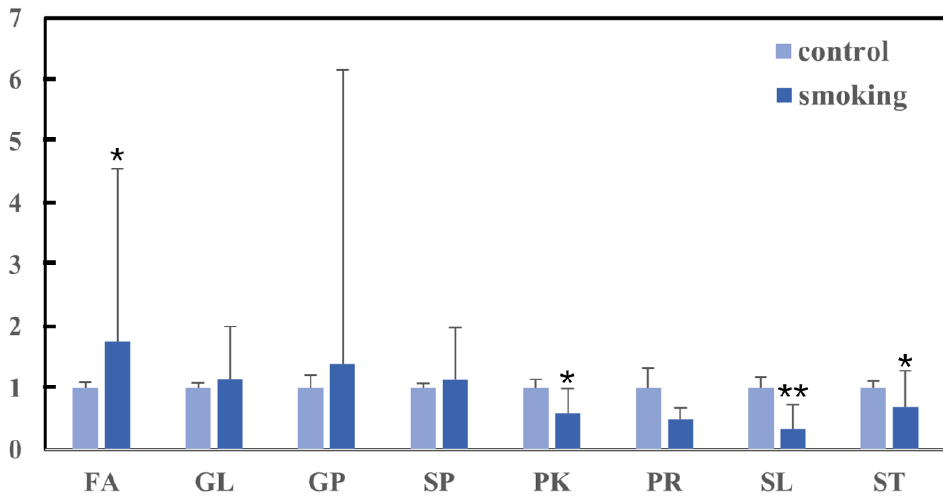
Figure 1. The relative amounts of the eight major lipids in the smoking and control groups. These units are ‘relative to the value for non-smokers, which is set at a value of 1’. ** p < 0.01; * p < 0.05.